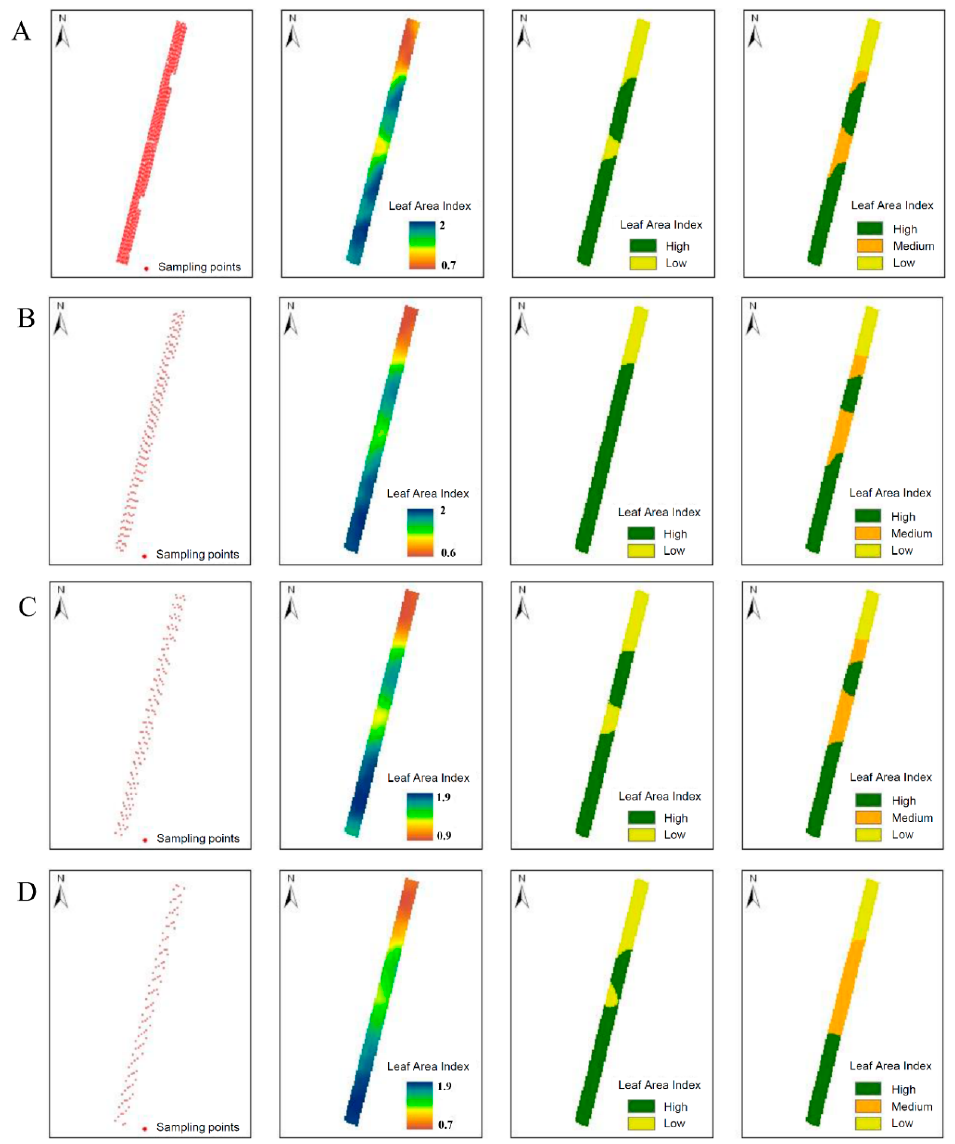
Figure 10. Sampling points, LAI raster maps, and LAI classified maps for different MTLS sampling schemes along the rows. The sampling sections are separated 1 m ( A ); 10 m ( B ); 15 m ( C ); and 20 m ( D ).